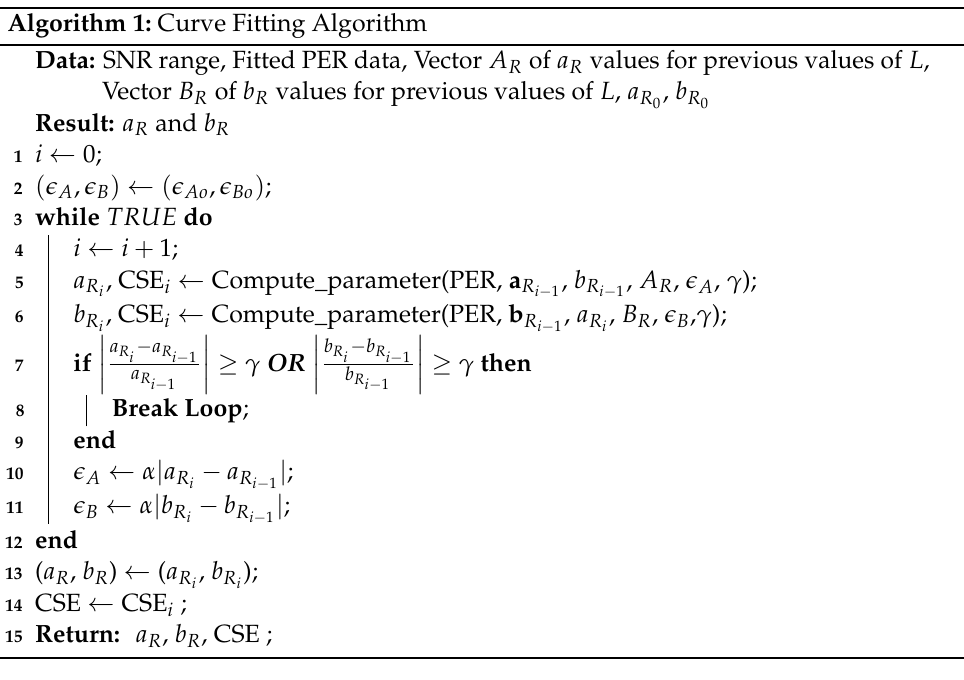
Algorithm 1: Curve Fitting Algorithm